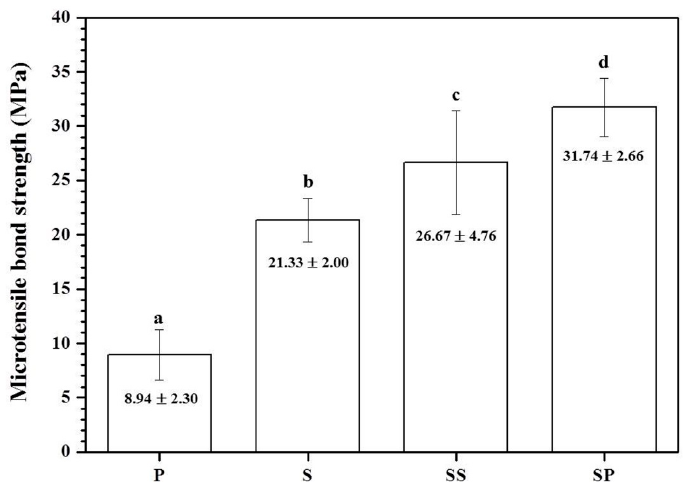
Figure 2. Tensile bond strength (TBS) of enamel bonded to 3Y-TZP after surface treatments. Bars indicate the standard deviation. P: Polishing; S: Sandblasting; SS: Sandblasting + SIE technique; SP: Sandblasting + MDP-containing silane primer. a–d: Groups shown with different letters were significantly different ( p < 0.05).